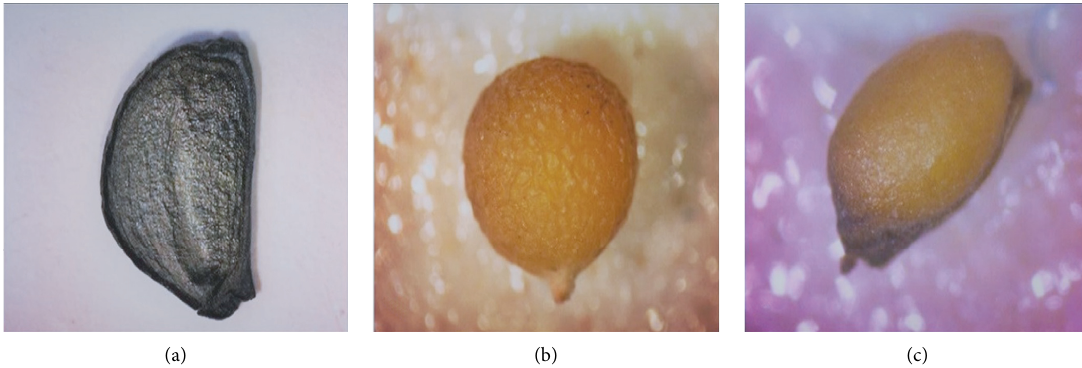
Figure 1: Seeds of A. lechuguilla (a), L. graveolens (b), and N. cespitifera (c) used in this research.